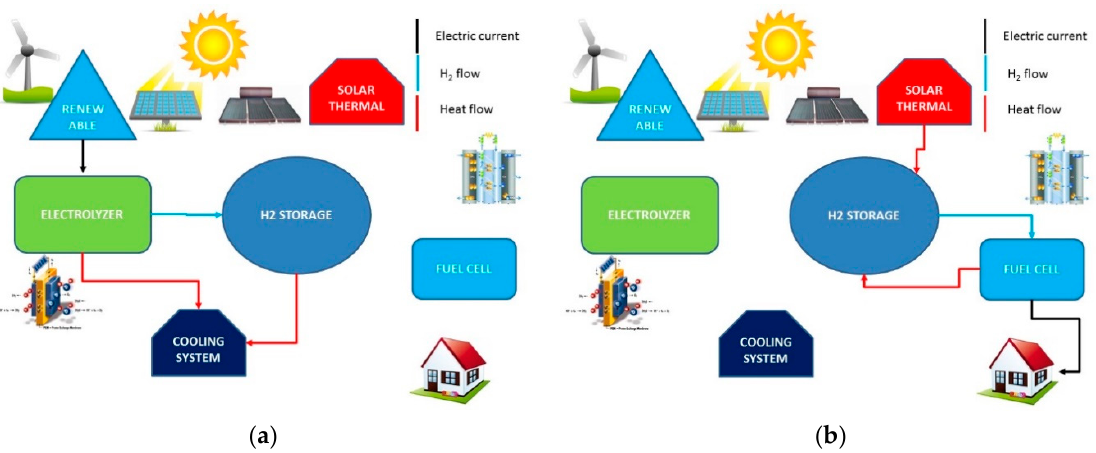
Figure 2. Flow of hydrogen, heat, and electricity during hydrogen production ( a ) and use ( b ).